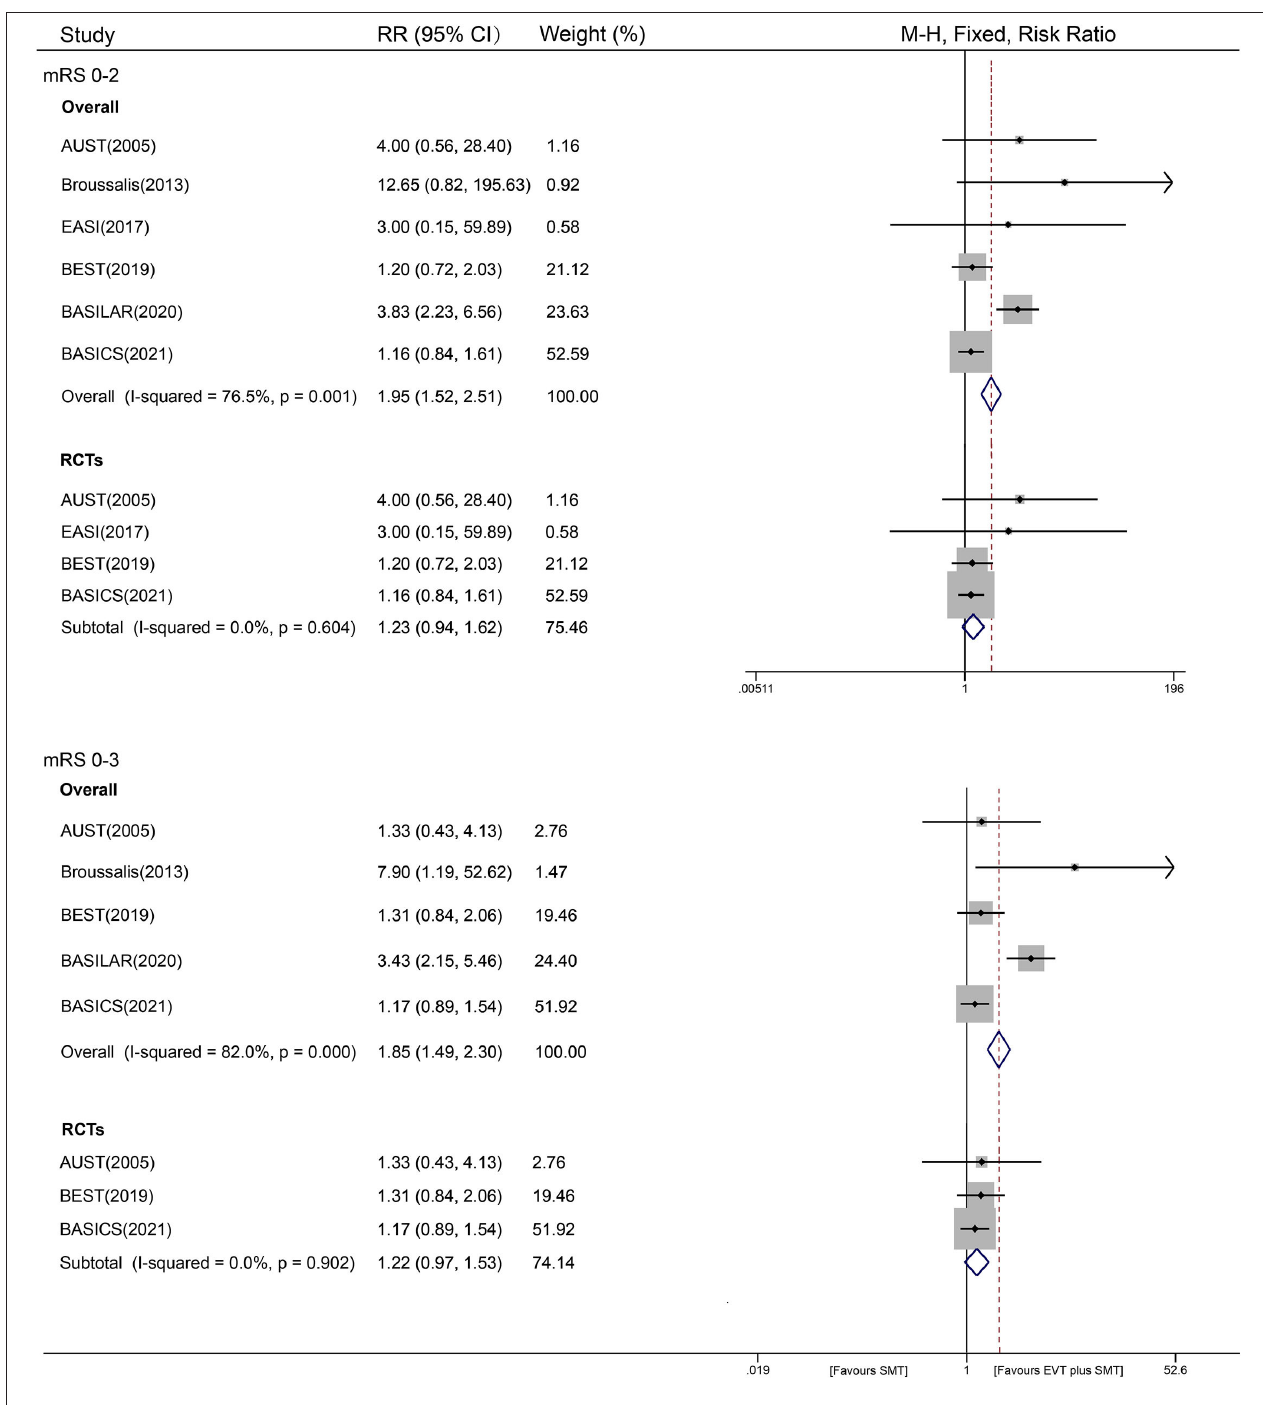
FIGURE 2 | Forest plot of mRS 0–2 or 0–3 with fixed-effect model.